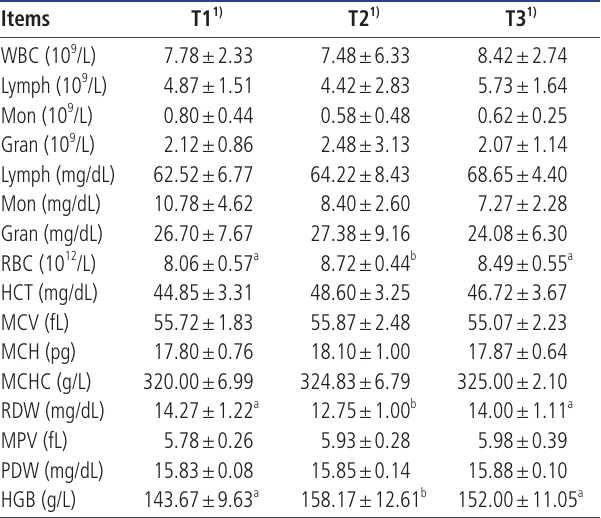
Table 3. Effect of mulberry leaves on hematological parameters of Sprague- Dawley rats at the end of recovery